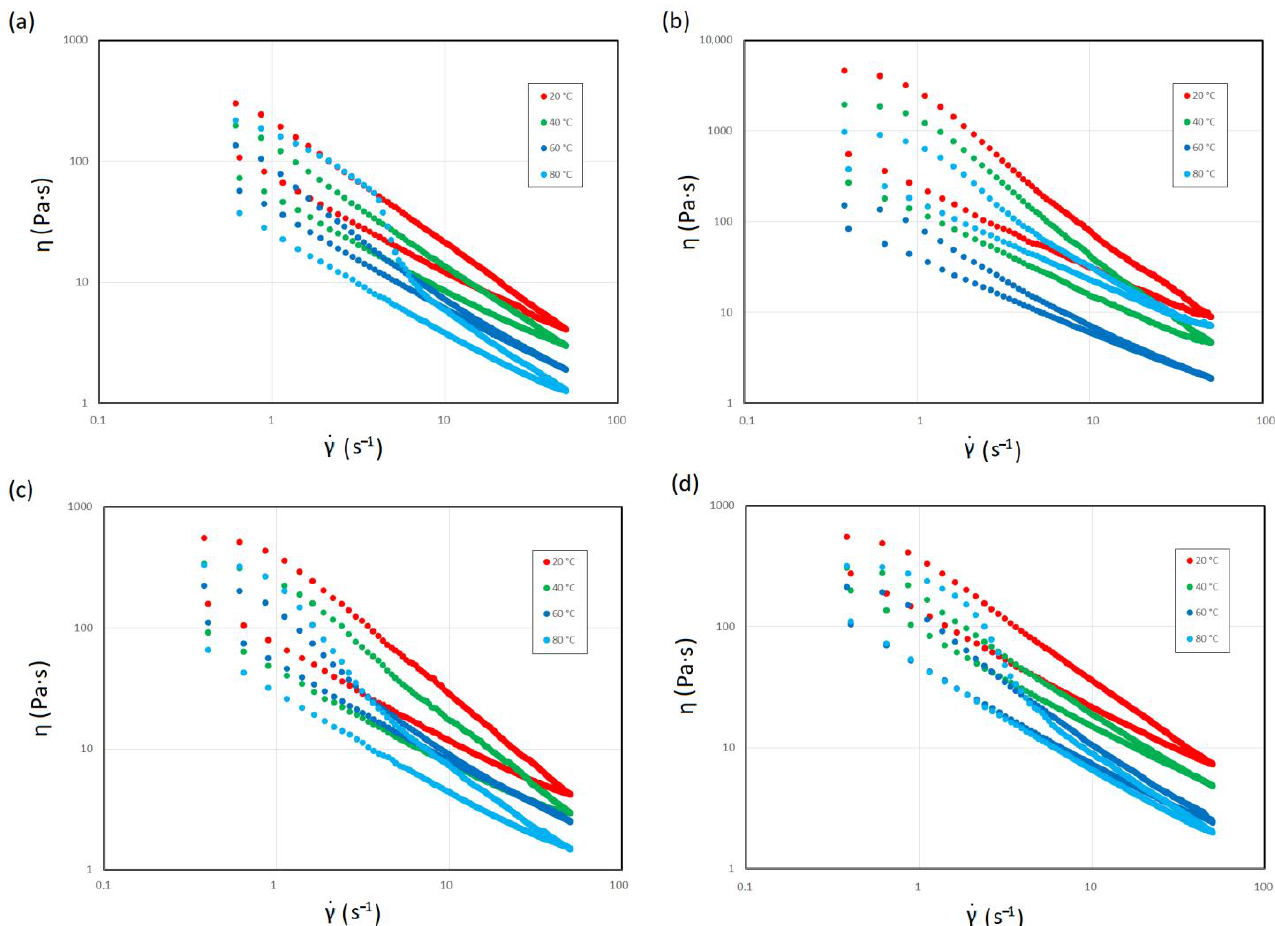
Figure 2. Viscosity curves of hot trubs as a function of shear rate at four temperatures: ( a ) hot trub from wort, 12.5° (70% malted + 30% unmalted barley); ( b ) hot trub from wort, 14.1° (100% malted barley); ( c ) hot trub from wort, 16.1° (55% malted + 45% unmalted barley); ( d ) hot trub from wort, 18.2° (55% malted + 45% unmalted barley).